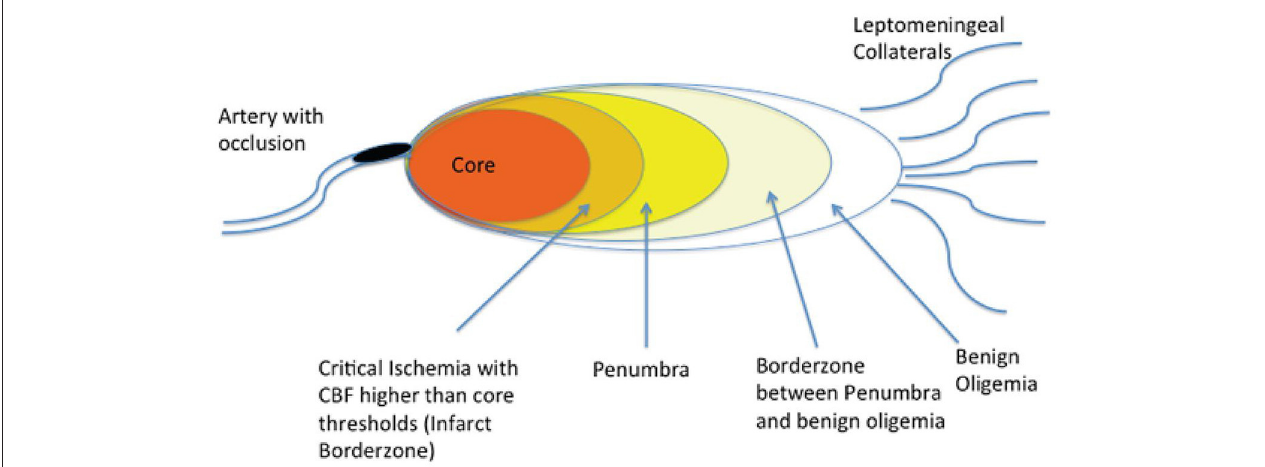
FIGURE 1 | Brain regions downstream from an acute arterial occlusion. Following a cerebral arterial occlusion, the downstream brain territory evolves into an area of irreversible infarction (core), an ischemic area that is potentially salvageable if timely recanalization is achieved, and areas of somewhat reduced blood flow that can withstand ischemia even if recanalization is not achieved (benign oligemia). (Reprinted from Goyal et al. ( 42). Copyright (2013) by Radiology. Reprinted with permission).